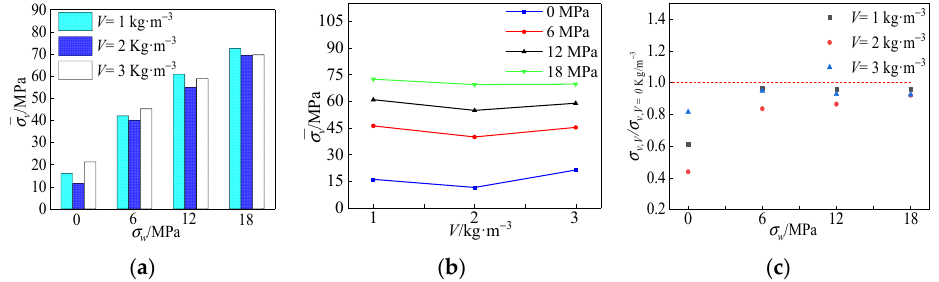
Figure 18. Effect of polypropylene fiber on peak stress: ( a ) influence of polypropylene fiber on peak stress; ( b ) relationship between peak stress and polypropylene fiber content; ( c ) normalized peak